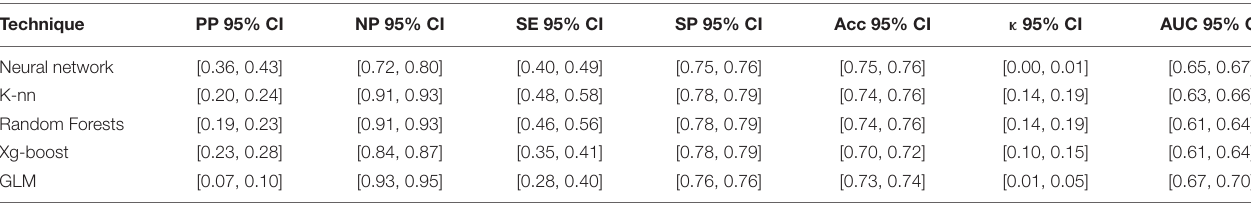
TABLE 10 | Confidence intervals of summary statistics for the predictive ability of the models built with five machine learning techniques in study 3b.